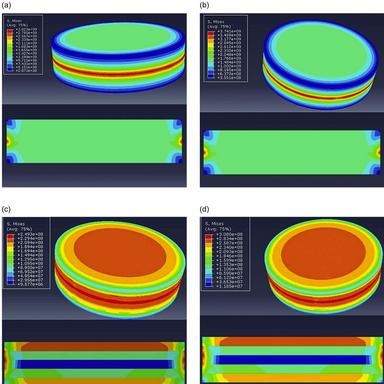
Stress Distribution of Material sintered in one step, above part was in three-dimensional geometry and below part was sectional view. (a)Two layers including Ta10W layer and YSZ layer heating from 25°Cto 1300 °C, (b)Two layers including Ta10W layer and YSZ layer heating from 25°Cto 1600 °C, (c)Five layers heating from 25°Cto 1300 °C, (d)Five layers heating from 25°Cto 1600 °C.